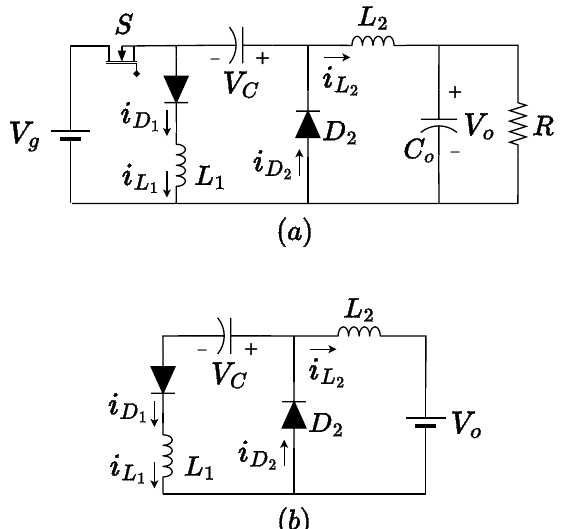
Figure 7. ( a ) Zeta-modified converter a with diode at the input port L 2 , ( b ) equivalent circuit when the transistor is